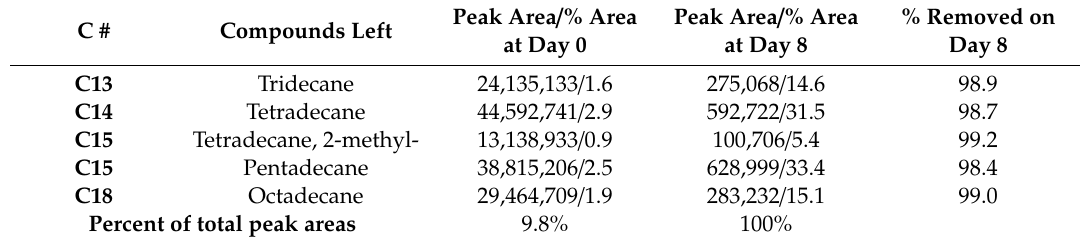
Table 3. TPHd constituents on Days 0 and 8 of Run III at a depth of 10 cm.